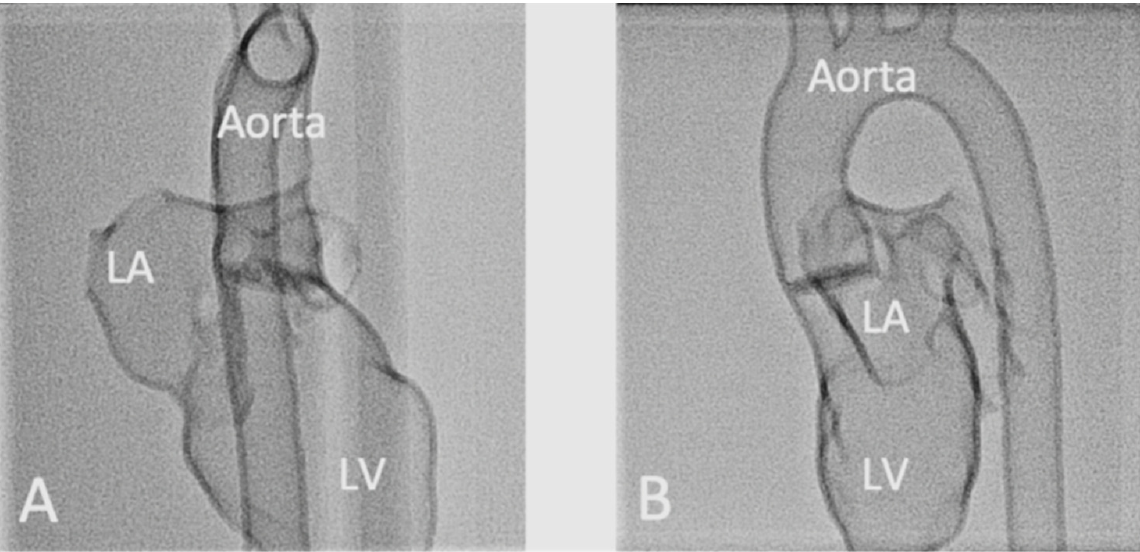
Figure 5. Influence of the projection levels on the anatomic representation during fluoroscopy of a 3D printed left heart model. Representation of a 3D printed heart model in anteroposterior ( A ) and lateral views ( B ). LA-left atrium, LV-left ventricle. Reprinted with permission under the open access from Brunner et al. [65].